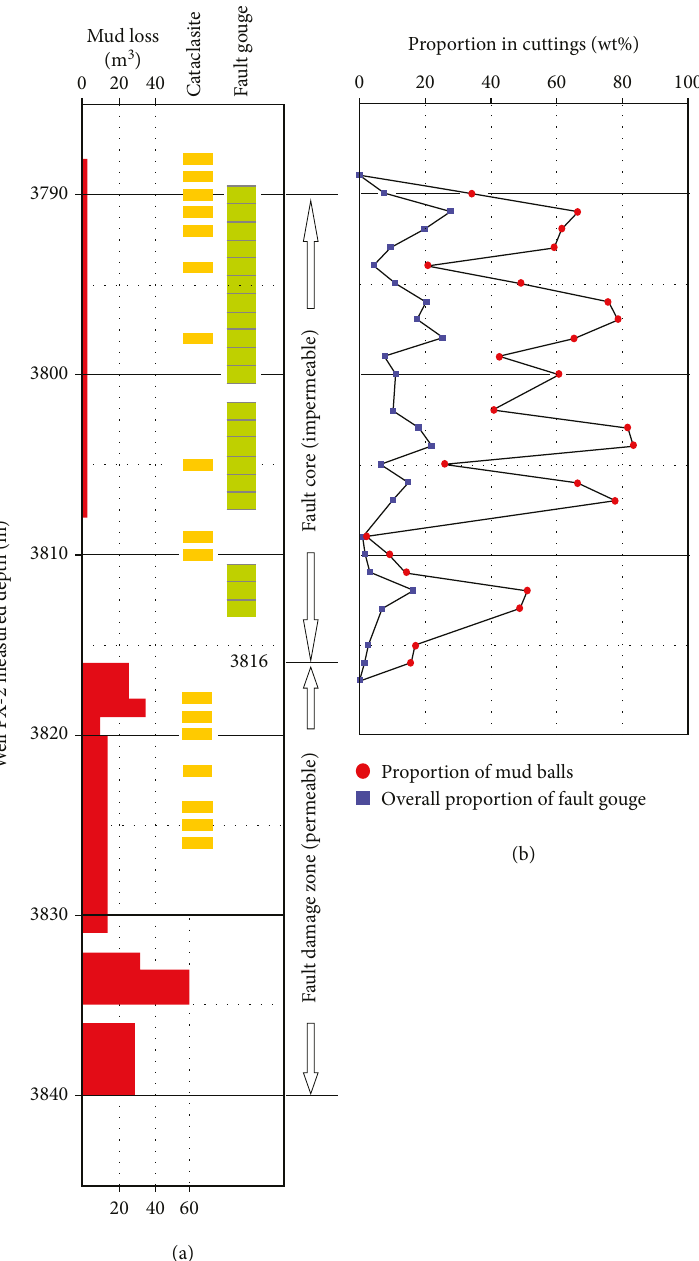
Figure 3: Enlargement of the intersection in Figure 2(b) between well PX-2 and the Namsong Fault, showing (a) reports of fault gouge, cataclasite, and loss of drilling mud, from drilling logs, and (b) proportions of fault gouge from subsequent laboratory analysis of cuttings. Modi fi ed from Figure O-3(e) of [5]. Many of the larger (centimetre-sized) cuttings from this depth range were “ mud balls ” containing large proportions of fault gouge and cataclasite; [5] provides further details. Interpretation of impermeable fault core and permeable fault damage zone, after [86,